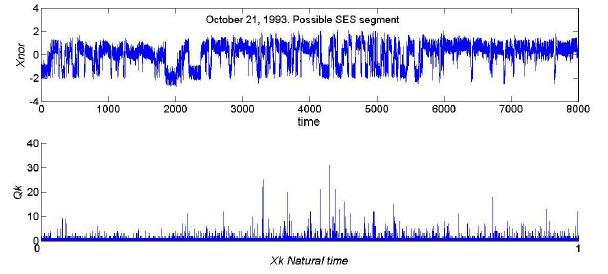
Figure 3. Excerpt of ACA1 on October 21, 1993, in conventional time (top) and in NTD (bottom).